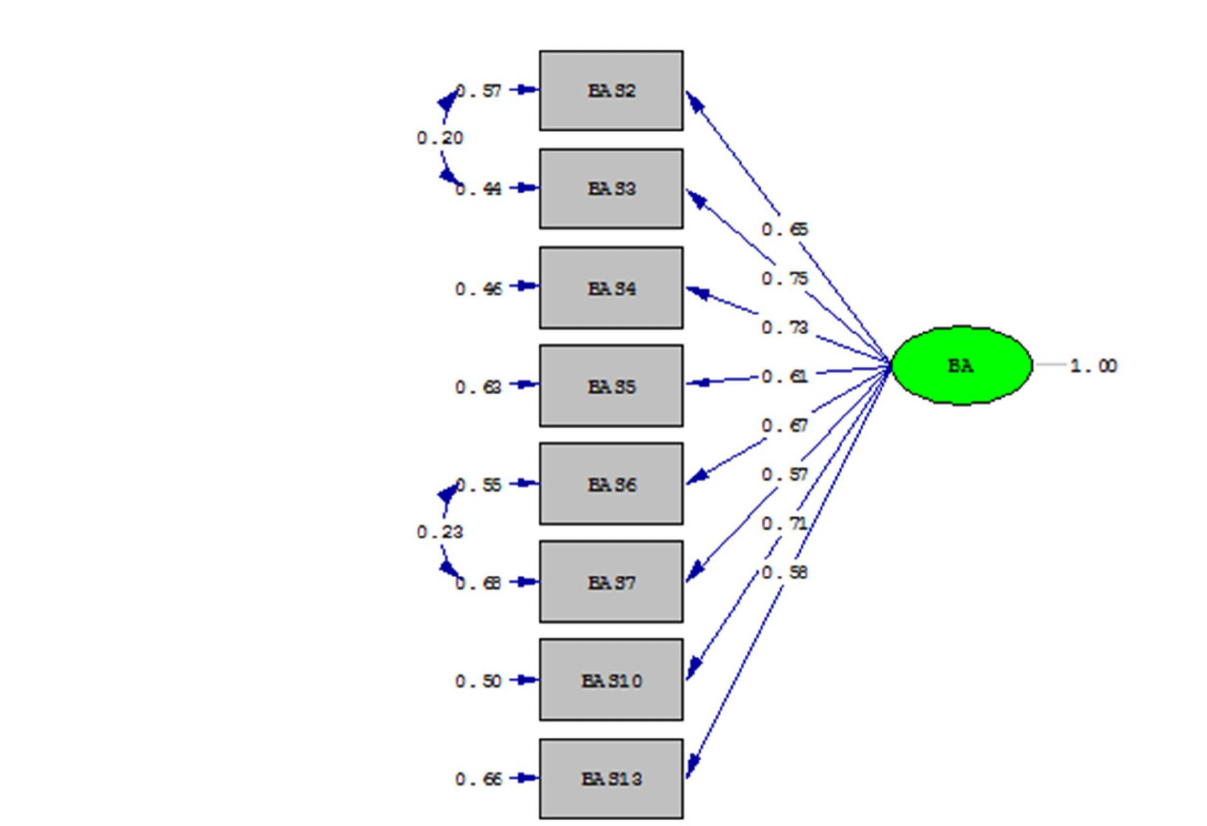
Figure 1. A graphic model of the unidimensional model of the Brazilian version of the BAS for the older